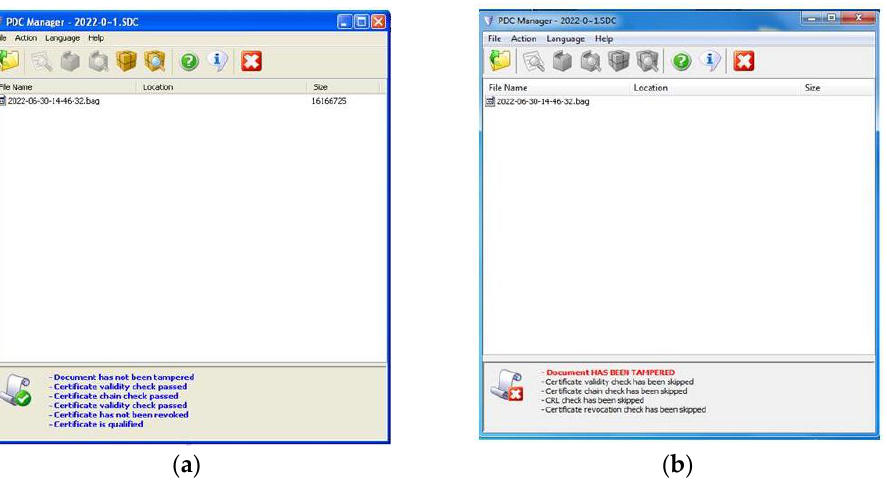
Figure 6. Digital signature verification. ( a ) Successful verification; ( b ) Failed Verification.